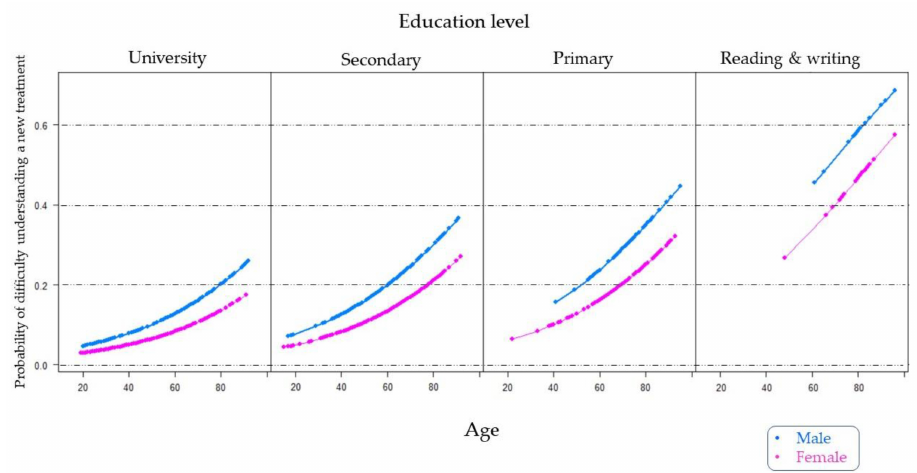
Figure 5. Estimation of the probability of difficulty in understanding a new treatment prescribed by the doctor according to the age of the patients, distinguishing them by their education level and gender.